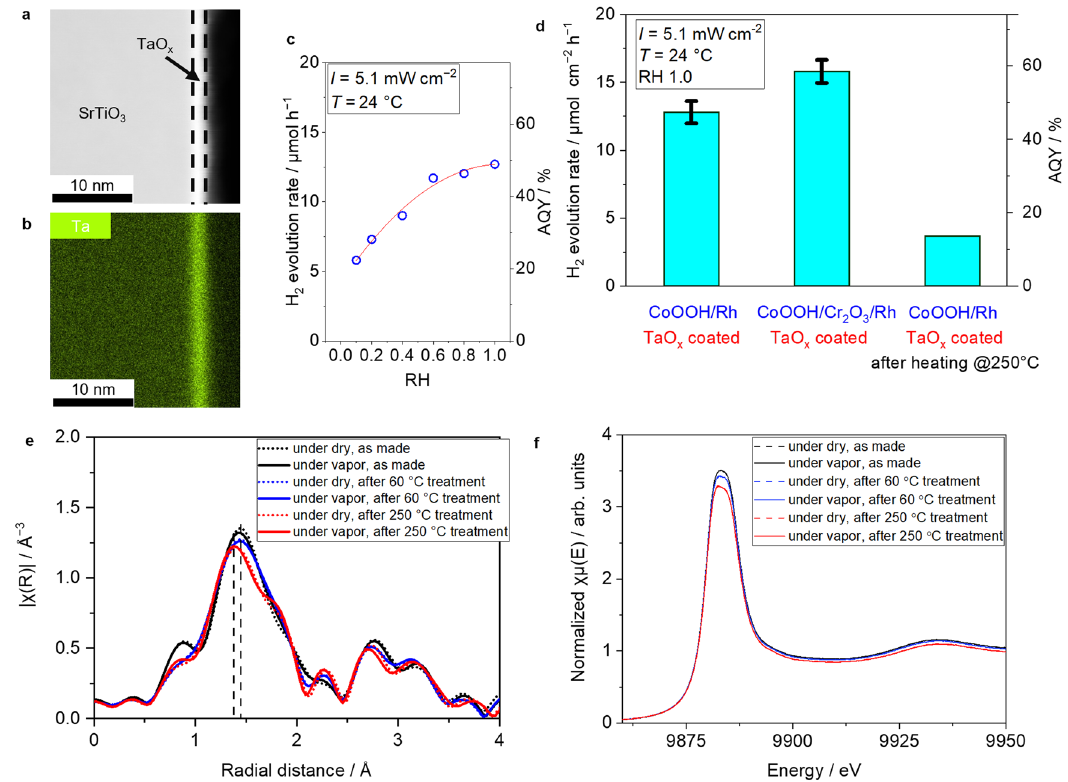
Fig. 4 | Thermal deactivation of TaO x coated SrTiO 3 :Al photocatalysts. a Dark standard error from other samples ( n =3). d Dependence of H 2 evolution rate of fi eld TEM image of CoOOH/Rh loaded SrTiO CoOOH/Rh loaded SrTiO 3 :Al coated with TaO x on relative humidity at 24°C. Light 3 :Al coated with TaO x and b its cor- responding EDS mapping of Ta. c H 2 evolution rate of TaO x coated SrTiO 3 :Al type source: 370nm LED (5.1mWcm − 2 ). e Fourier transformed Ta L III EXAFS patterns of photocatalystsbeforeandafterthermaltreatmentandregenerationprocess.These CoOOH/Rh loaded SrTiO 3 :Al coated with TaO x recorded at 24°C under dried demonstrations were under saturated water vapor balanced with Ar at 24°C condition(dashed)and(solid)afterthermaltreatment,and f correspondingXANES (10mLmin − 1 , p H2O =2.9kPa).Lightsource:370nmLED(5.1mWcm − 2 ).Errorbarsare region of Ta L III XAFS spectra of TaO x coated, CoOOH/Rh loaded SrTiO 3